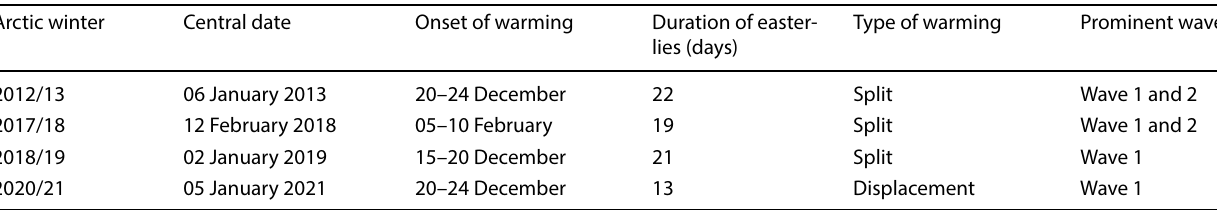
Table 1 Major warming (MW) characteristics in recent Arctic winters